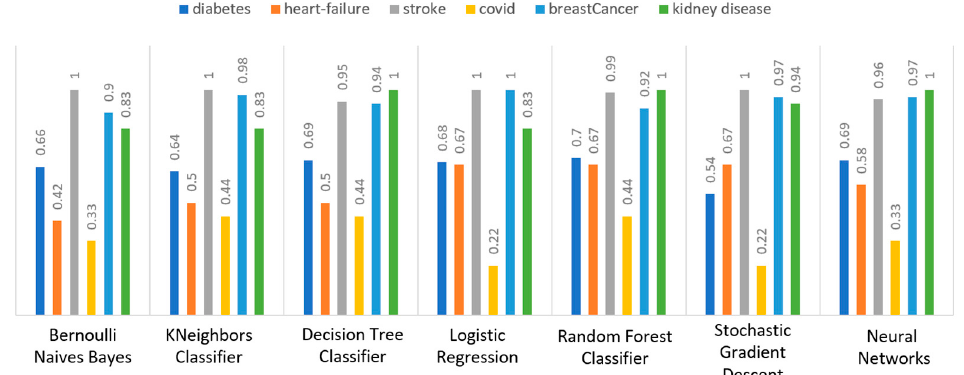
Figure 11. Precision results of ML models for each use case.